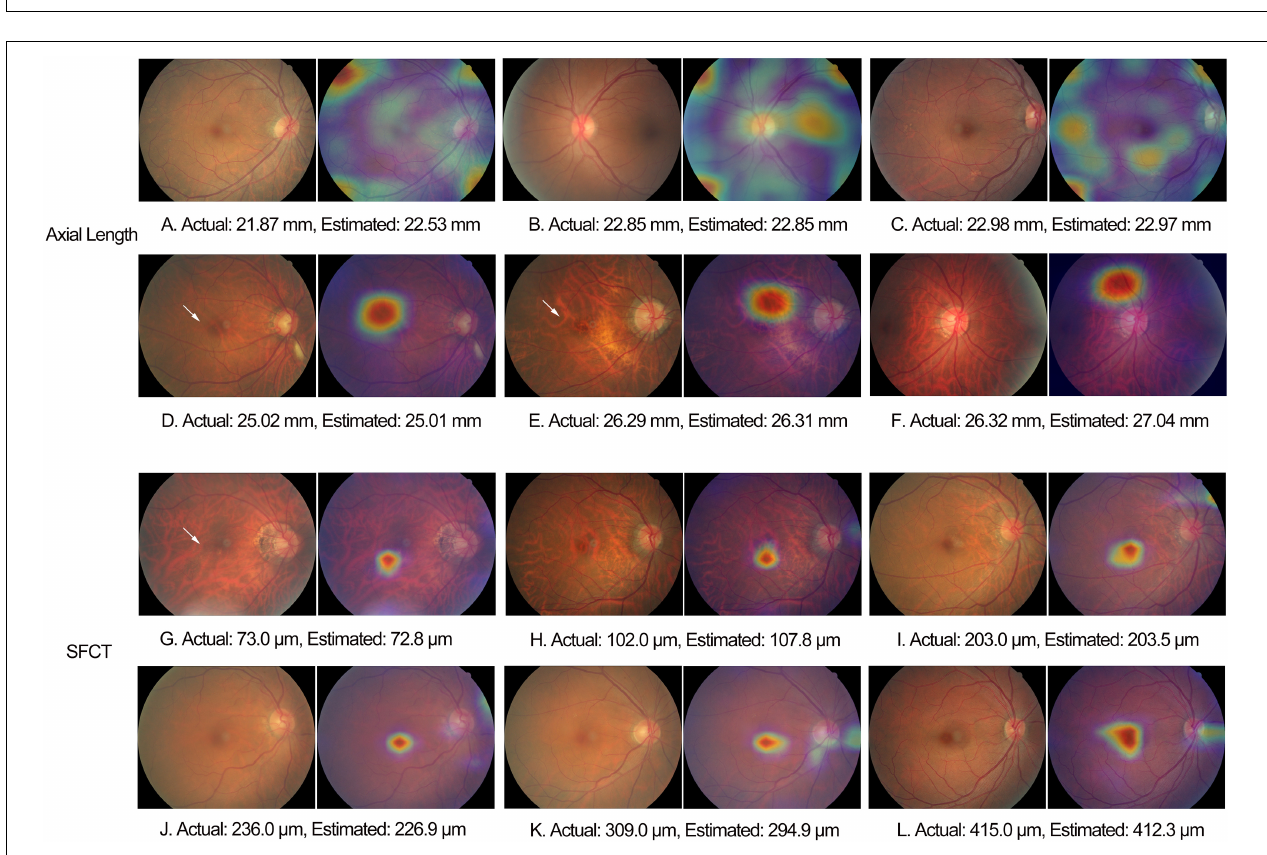
FIGURE 4 | Bland–Altman plots comparing the ( A ) actual and estimated axial length and ( B ) subfoveal choroidal thickness (SFCT). X -axis: mean of axial length or SFCT. Y -axis: measured values minus the estimated values. The mean differences and the 95% confidence limits of the difference are shown by the three dotted